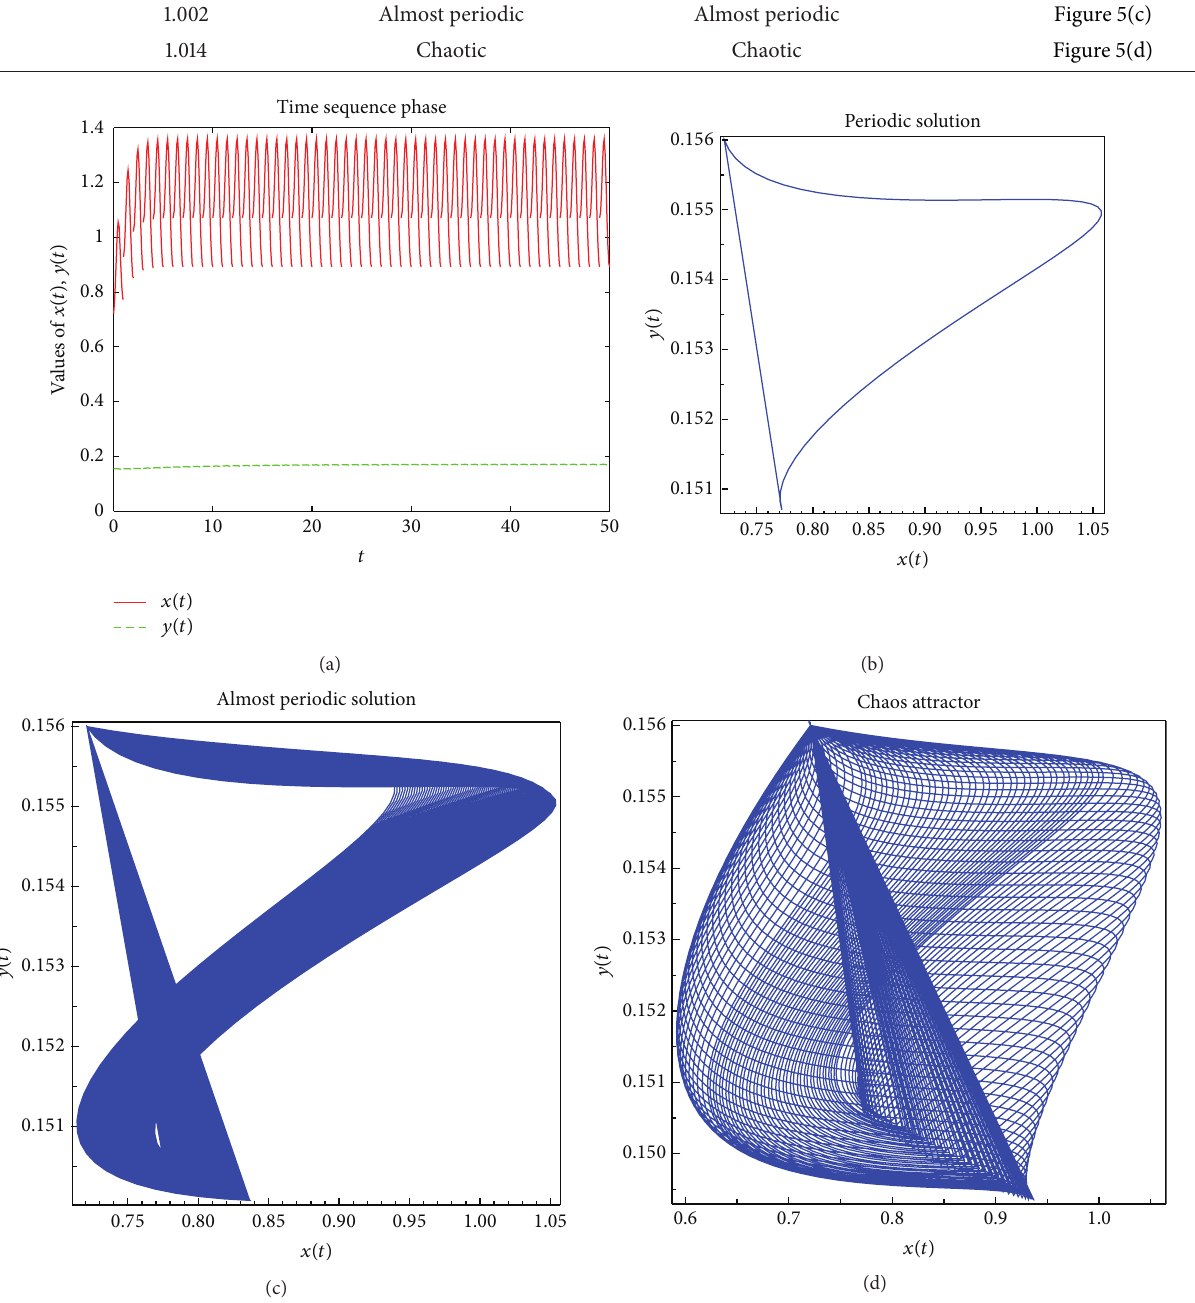
Figure 5: Dynamical behavior of system (3); here, we take initial value (𝑥(0),𝑦(0)) = (0.721, 0.156) . ) 𝑚−2 −𝛿𝑐 (𝑡) 𝑀 (𝑚 − 1) (𝑚 By calculation, conditions ( H 1 ) – ( H 5 ) , ( H 9 ) , and ( H 10 ) 2 1 2 } 𝑘 + 𝑚 1 ⋍ 0.5498 > 0. (65)